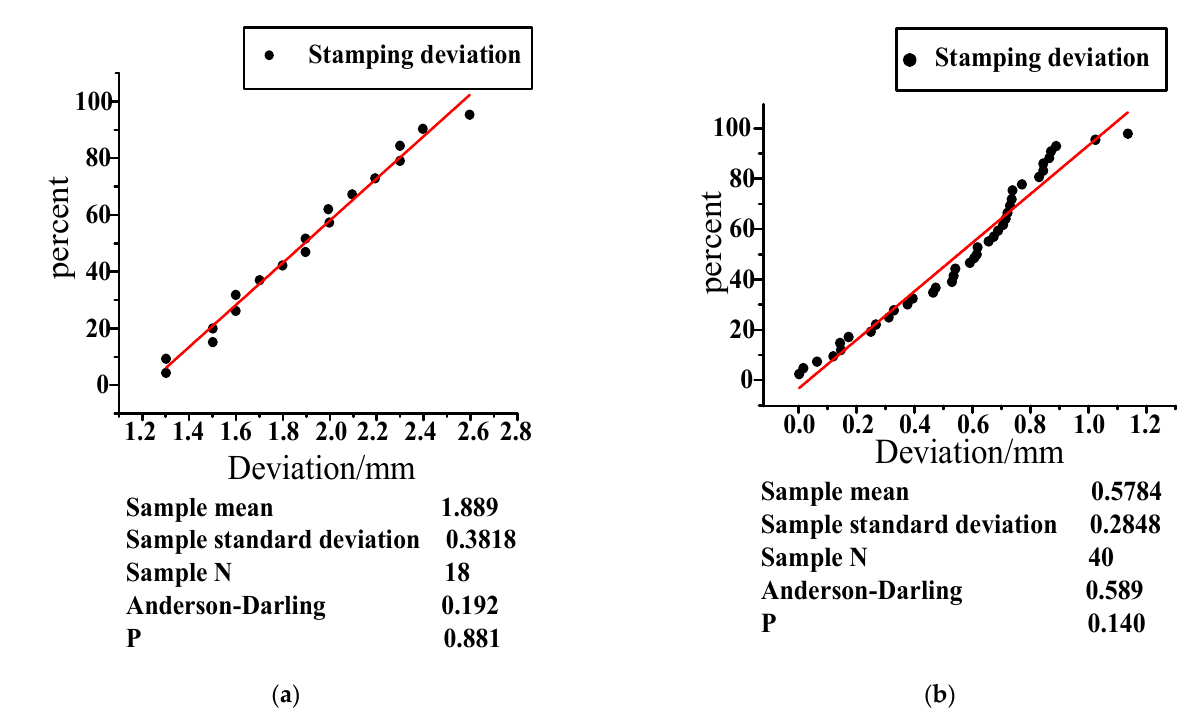
Figure 15. Deviation statistical chart of door position. ( a ) Dimension deviation diagram before improvement; ( b ) improved dimensional deviation diagram. The red line is a standard normal detection line, which is automatically generated by Minitab. The closer the black dot is to the red line, the more the data conforms to the normal distribution.